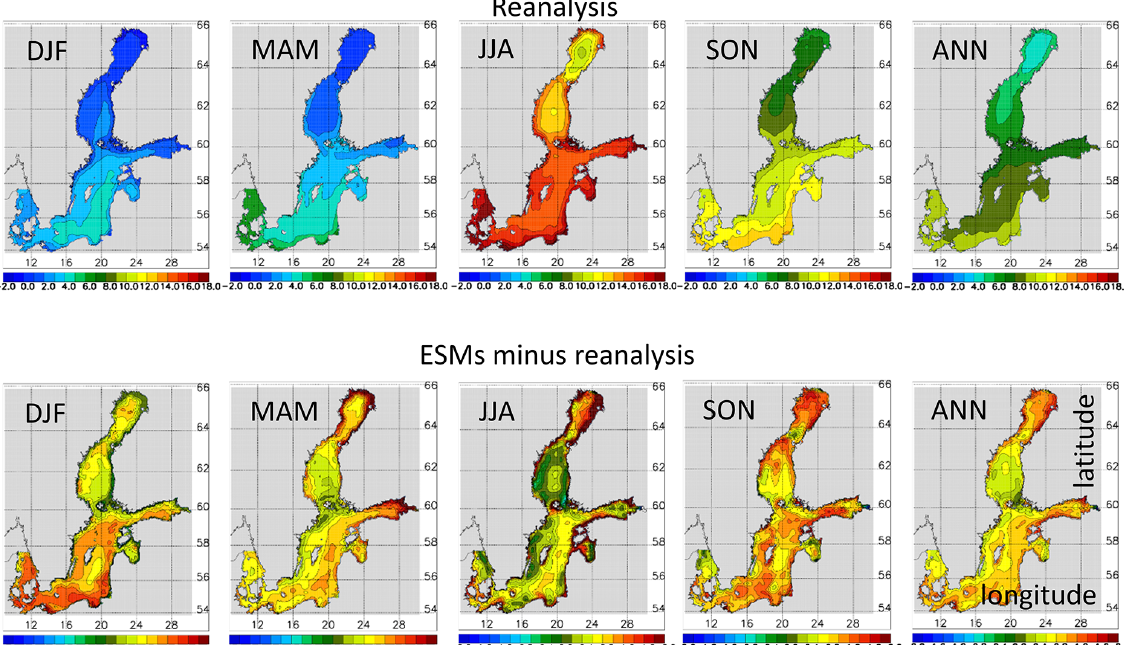
Figure 4. Upper panels: annual and seasonal mean sea surface temperature (SST, in ◦ C) in a reanalysis of data from 1970 to 1999 (Liu et al., 2017). Lower panels: difference between the climatologies of the ensemble mean of the regionalised ESMs used in BalticAPP (Saraiva et al., 2019a) and CLIMSEA (Meier et al., 2021) during the historical period (1976–2005) and those of the reanalysis data. From the left to right: winter (December–February, DJF), spring (March–May, MAM), summer (June–August, JJA), autumn (September–November, SON) and annual (ANN) mean SSTs or SST differences.